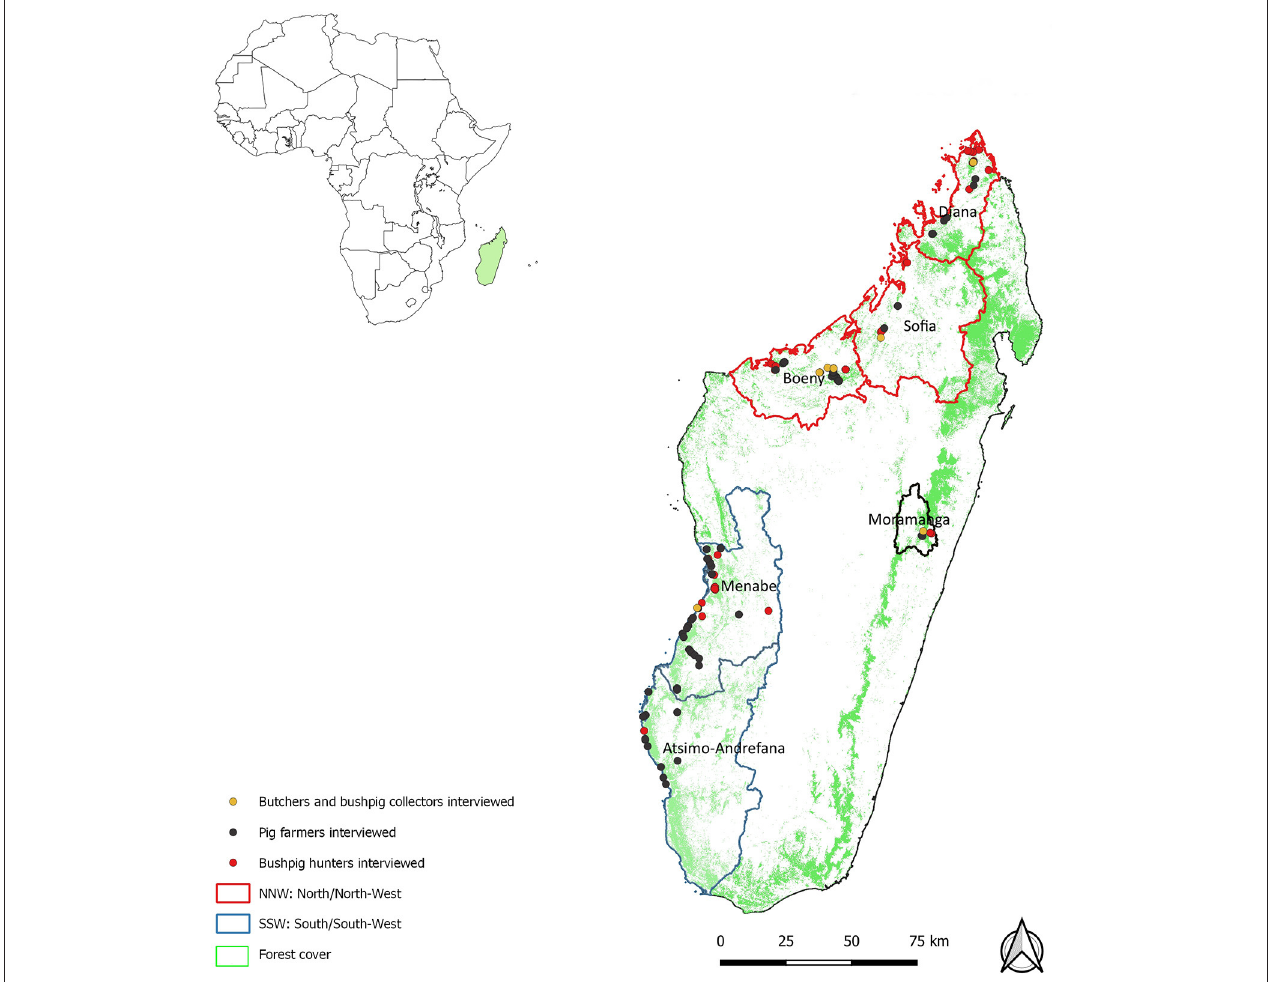
FIGURE 1 | Spatial distribution of stakeholderqs interviewed during a survey on health and socioeconomic aspects of bushpig hunting in Madagascar,